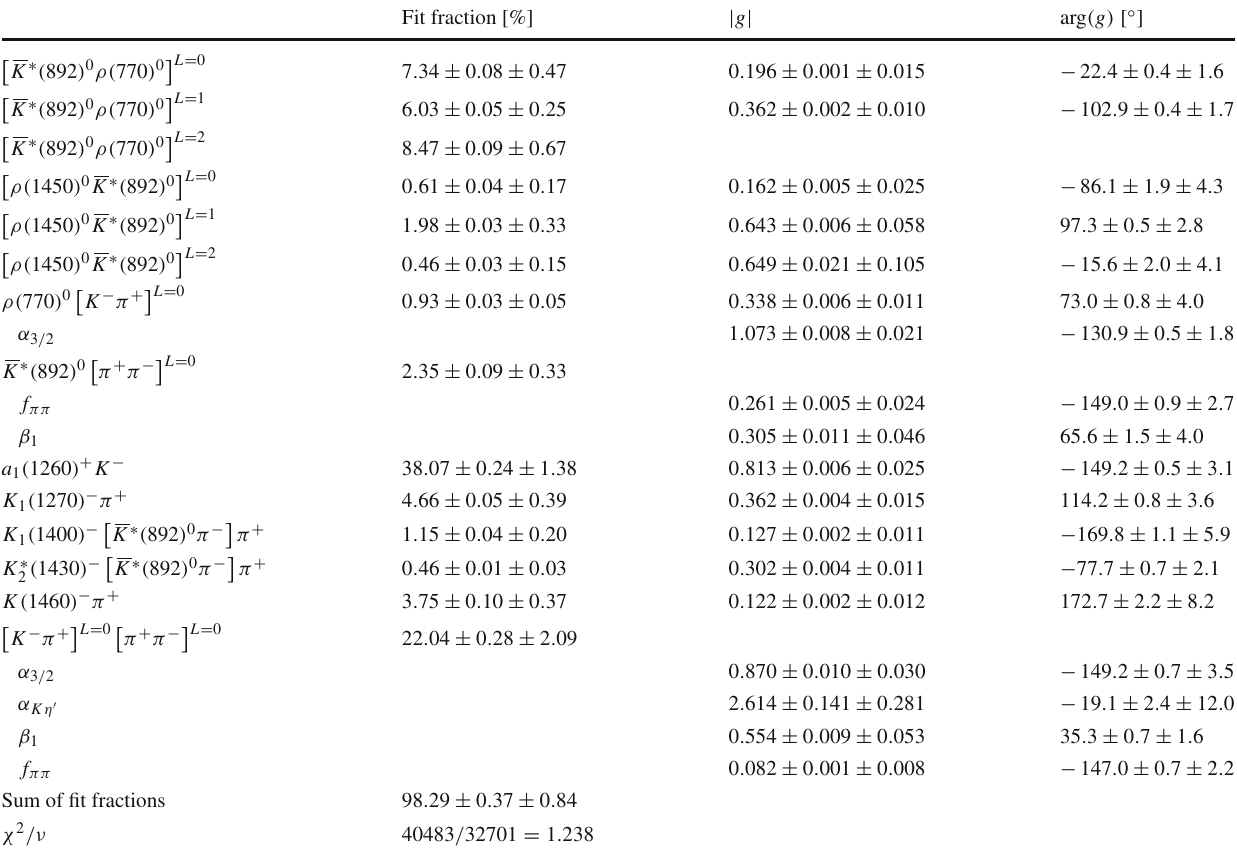
Table 2 Fit fractions and coupling parameters for the RS decay D 0 → K − π + π + π − . For each parameter, the first uncertainty is statistical and the second systematic. Couplings g are defined with respect to the cou-